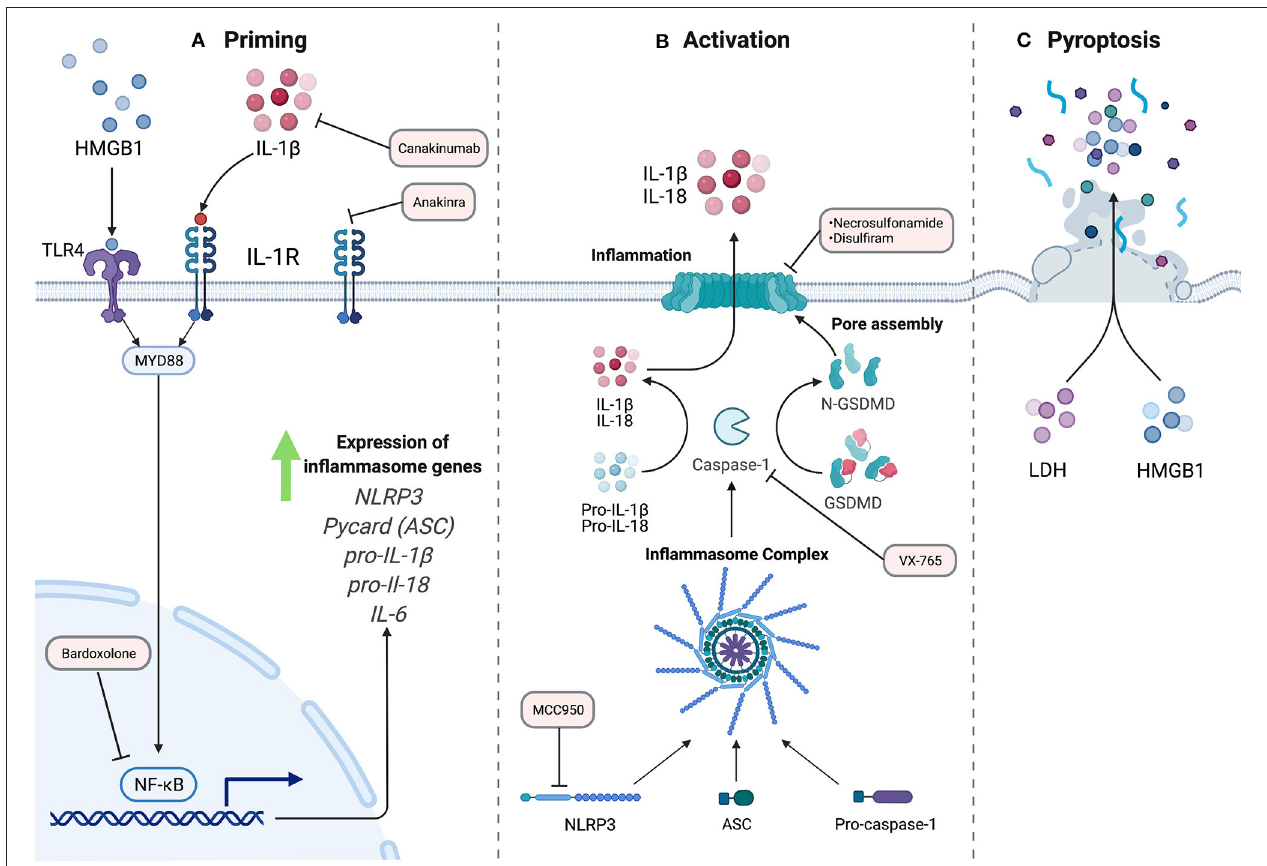
FIGURE 1 | The NLRP3 Inflammasome Pathway. A two-signal model for NLRP3 inflammasome activation. (A) Priming, signal 1, is accomplished by extracellular ligands through receptors such as Toll-like receptors. This results in activation of transcription factor NF- κ B and subsequent upregulation of inflammasome machinery and pro-inflammatory components. (B) Activation, signal 2, which can be achieved by a variety of stimuli resulting in the assembly of the inflammasome complex. Activated caspase-1 cleaves inflammatory cytokines, including pro-IL-1B and pro-IL-18 into their active forms. Additionally, GSDMD is cleaved to allow for N-terminal oligomerization and pore formation at the plasma membrane for release of mature cytokines. (C) In some conditions, the cell can undergo pro-inflammatory cell death termed pyroptosis, with frank rupture of the cell, and subsequent release of large macromolecules into the extracellular space, including danger-associated molecular patterns like HMGB1, and pro-inflammatory molecules like ATP, histones, and nucleic acids. The red rectangles indicate steps in the inflammasome pathway that can be targeted pharmacologically, and current agents that work at these